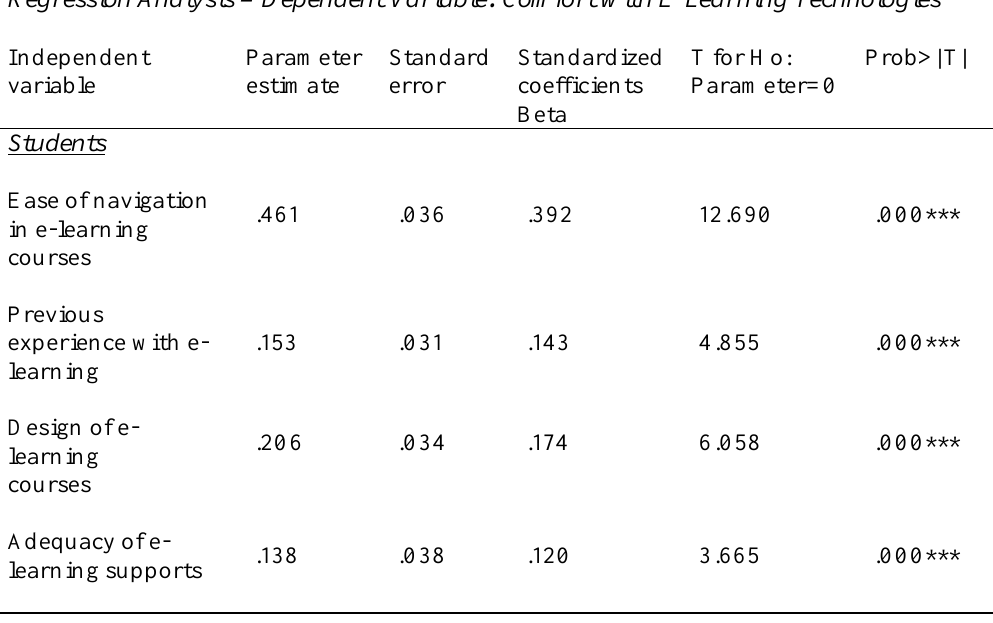
Regression Analysis – Dependent Variable: Comfort with E-Learning Technologies Independent